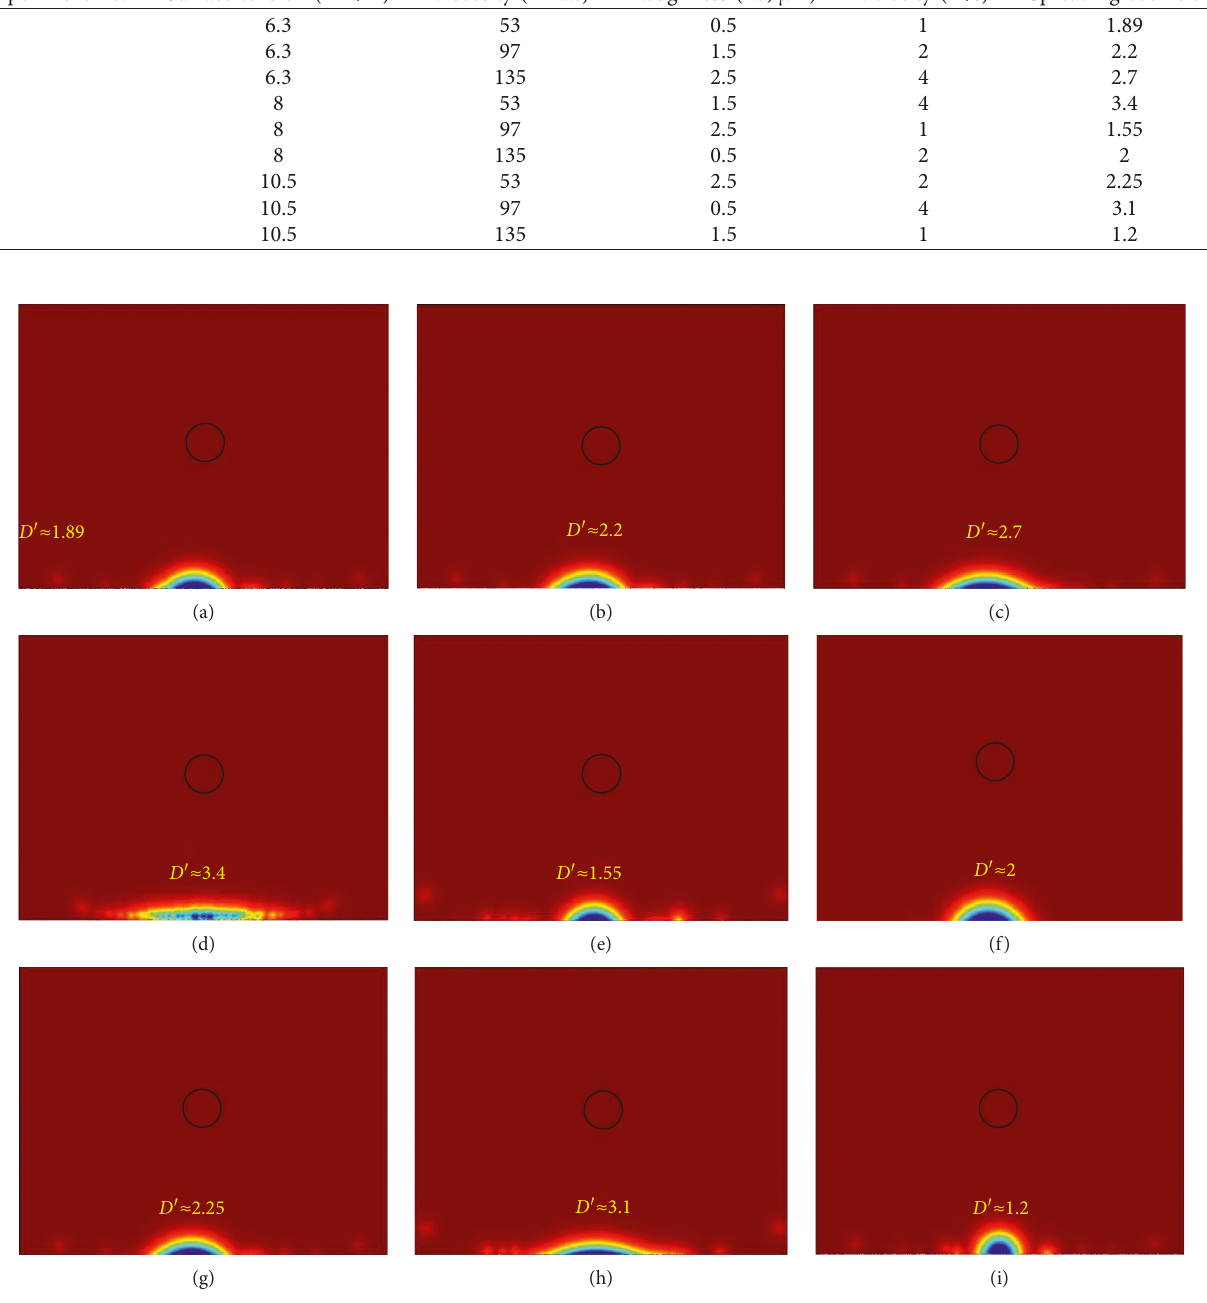
Figure 5: Orthogonal experimental simulation results.